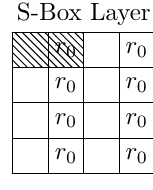
Figure 4: Examples of what an adversary can observe in the masked Midori (similarly in Skinny and Prince ) by placing a probe in a masked S-box pair or in the linear layer. We include the dynamic randomness (with r